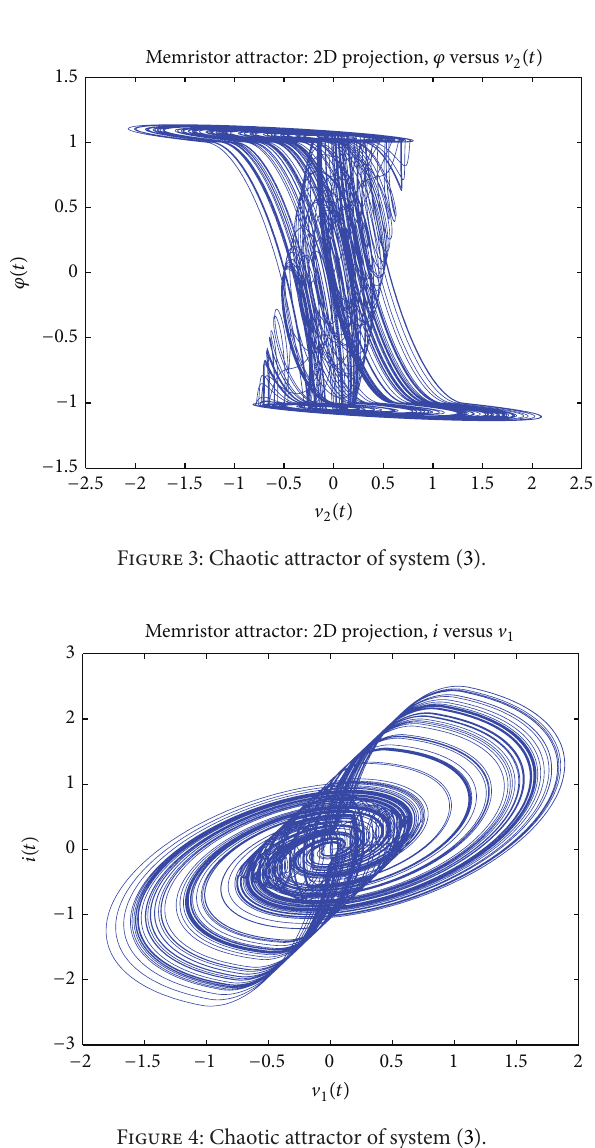
Figure 4: Chaotic attractor of system (3).